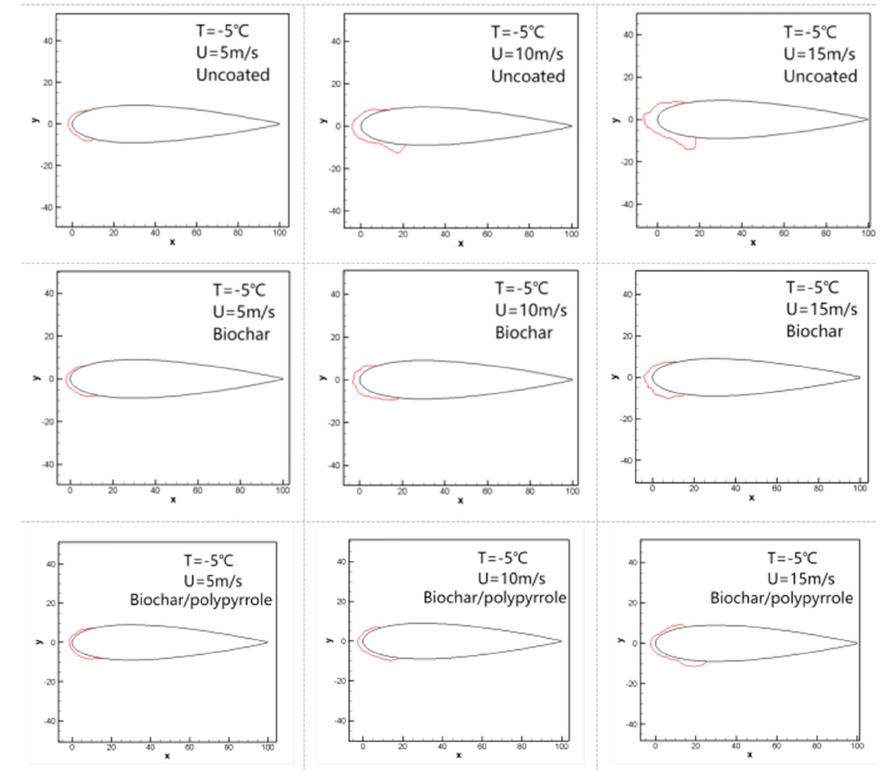
Figure 7. Photos of blade icing of uncoated coating, biochar coating, and biochar/polypyrrole coat- ing at − 10 °C and 10 m/s.